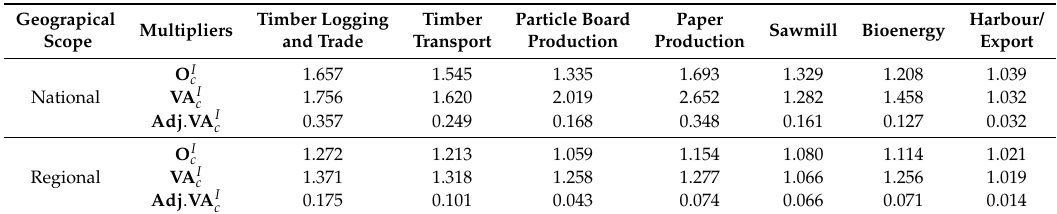
Table 2. Multipliers to estimate REs from the single participants’